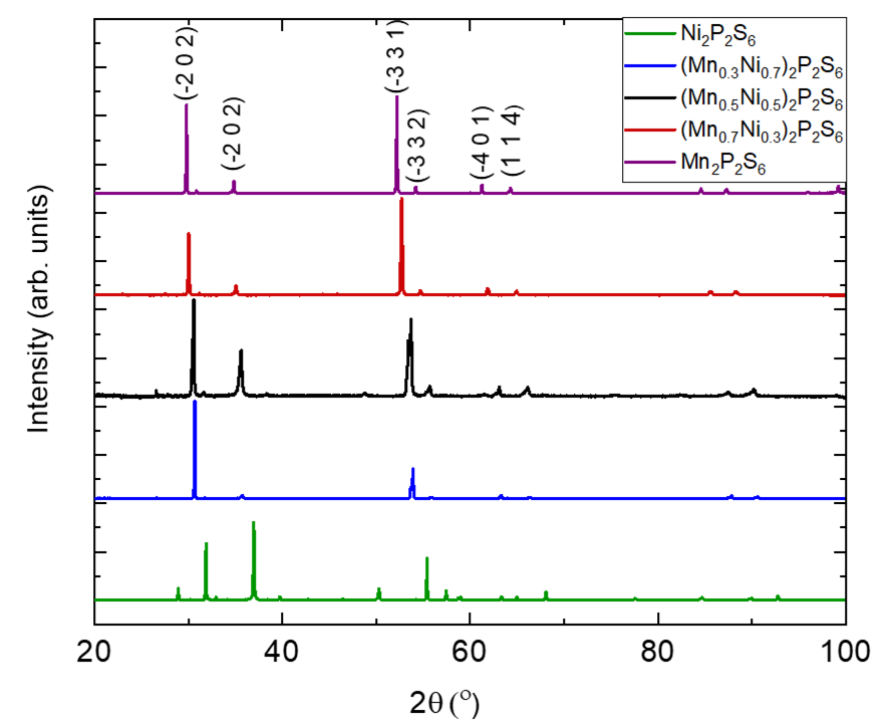
Figure 3. pXRD patterns of (Mn 1-x Ni x ) 2 P 2 S 6